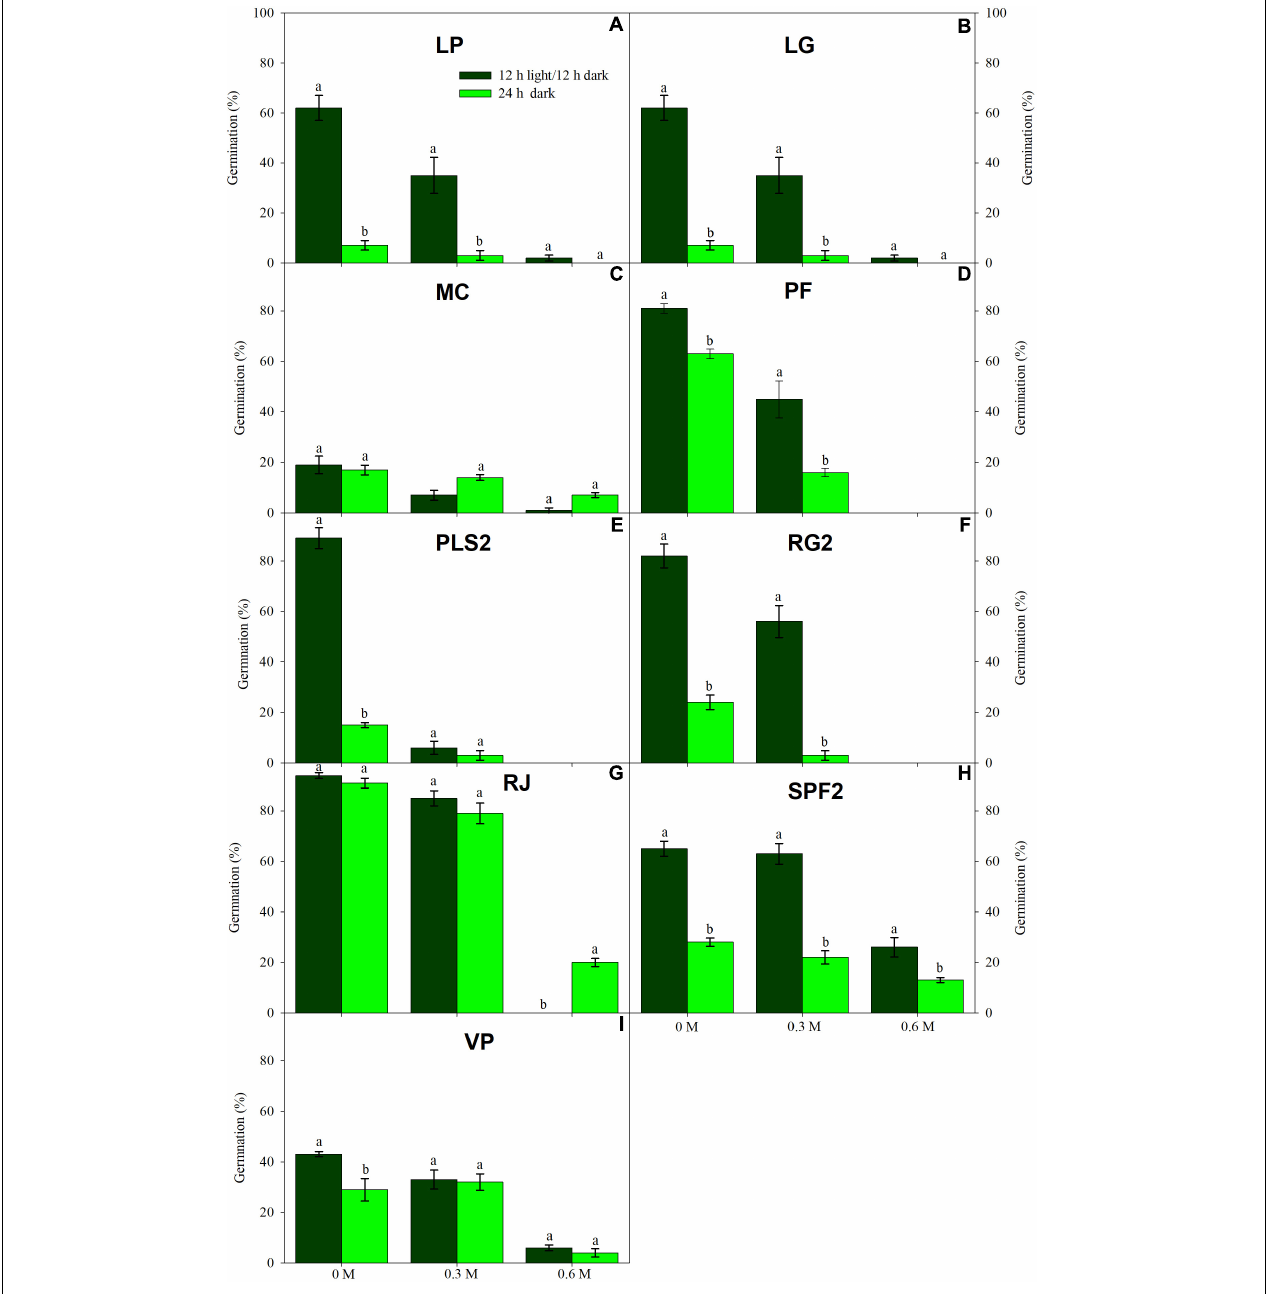
FIGURE 2 | Germination in light (dark green) and dark treatments (light green) under three water PEG6000 concentrations for the remaining nine wetland species occurring in Jiujiang, China. Vertical bars denote ± SE around the mean. Within features, different lowercase letters indicate significance at P ≤ 0.05. Vertical bars denote mean ( ± SE). Within features, different lowercase letters indicate significance at P ≤ 0.05. For more details on each study species, see Table 1